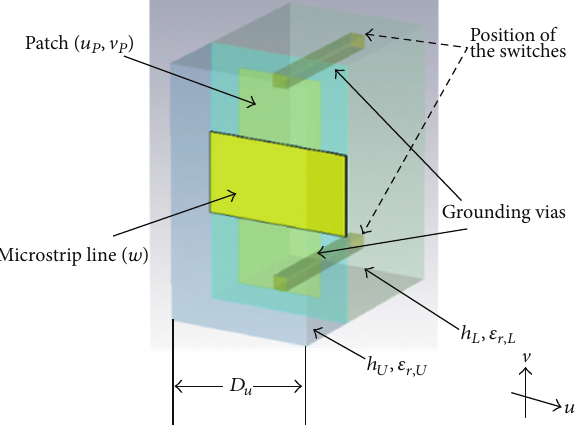
Figure 1: Single unit